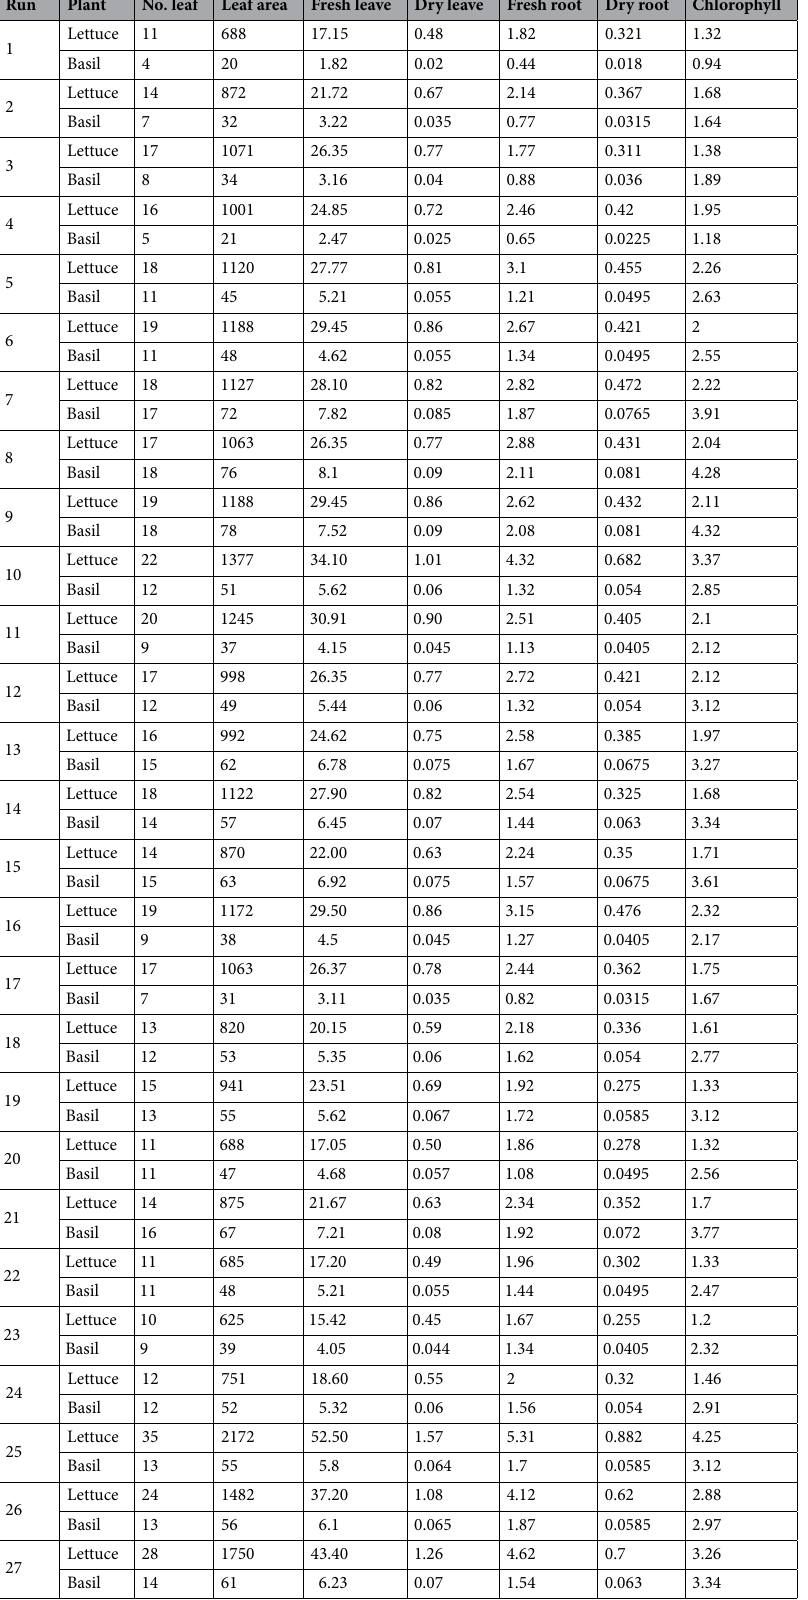
Table 5. The mean of calculated basil and lettuce growth parameters and chlorophyll in three replicates per each